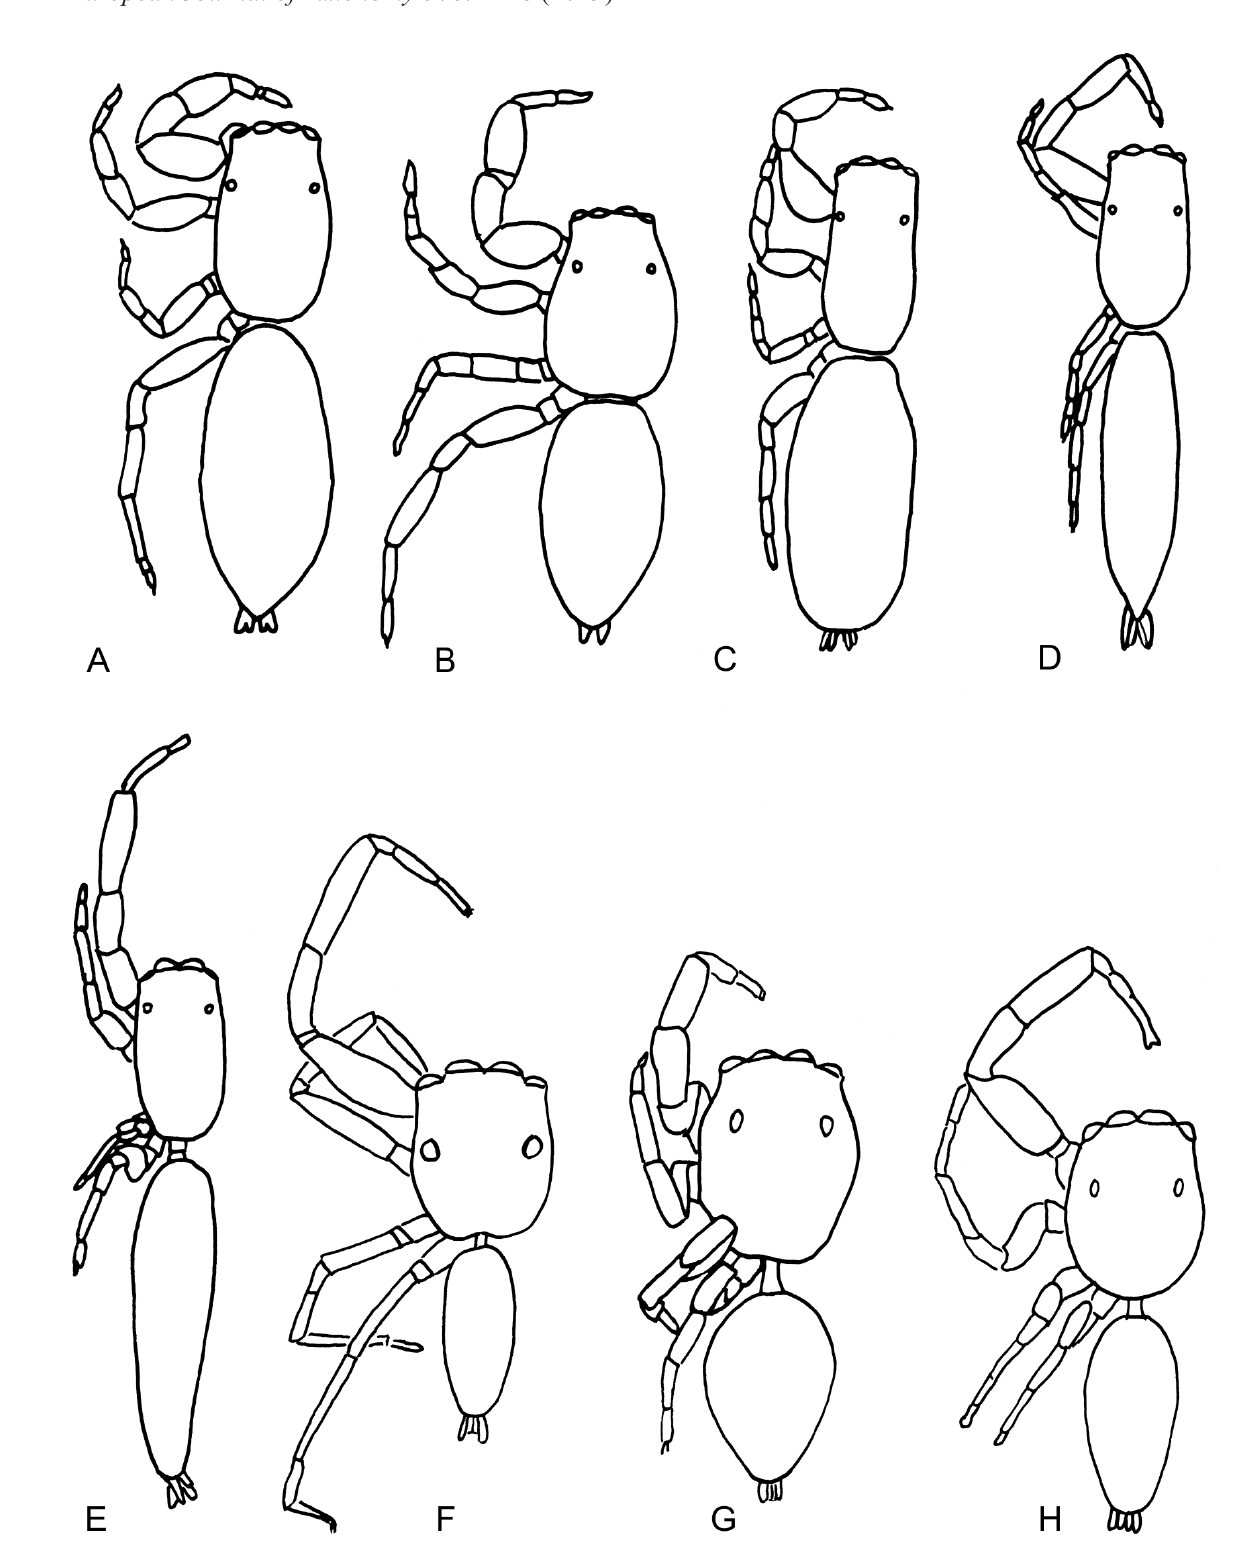
Fig. 1. Habitus of Corambis Simon, 1901 and related genera of Australasian Astioida. A .